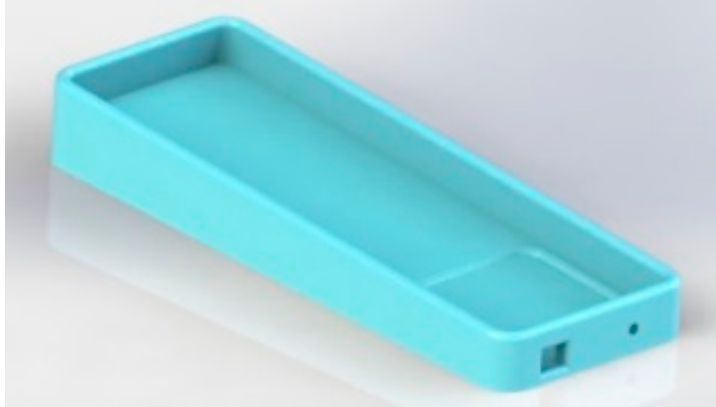
Figure 6. Surface concept 6.